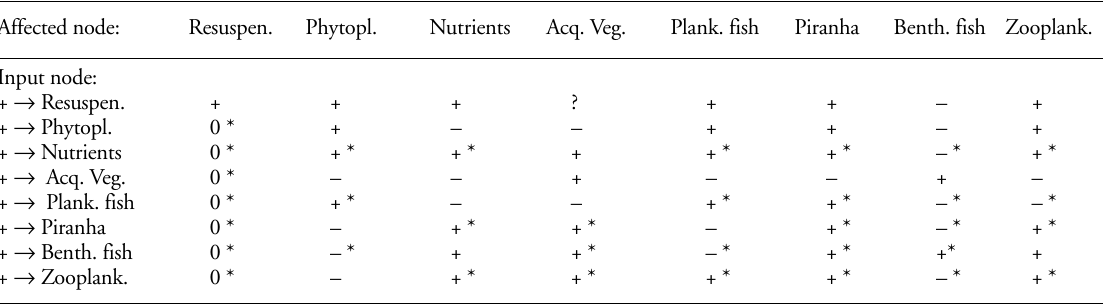
Table 3. Prediction table for an alternative qualitative model for feedback between system variables in the neotropical wetland (Esteros del Ibera). Model variables which have been affected include: nutrients (considered those that would effect vegetation growth), aquatic macrophytes (rooted emergent and submersed aquatic vegetation), phytoplankton, resuspension of lagoon sediment (consisting of fine organic material), zooplankton, small planktivorous fish, piranha and benthivorous fish. The asterisk indicates where the equilibrium change differs from the original model. Differences from the shallow water model are indicated by (*). Affected node: Resuspen. Phytopl. Nutrients Acq.